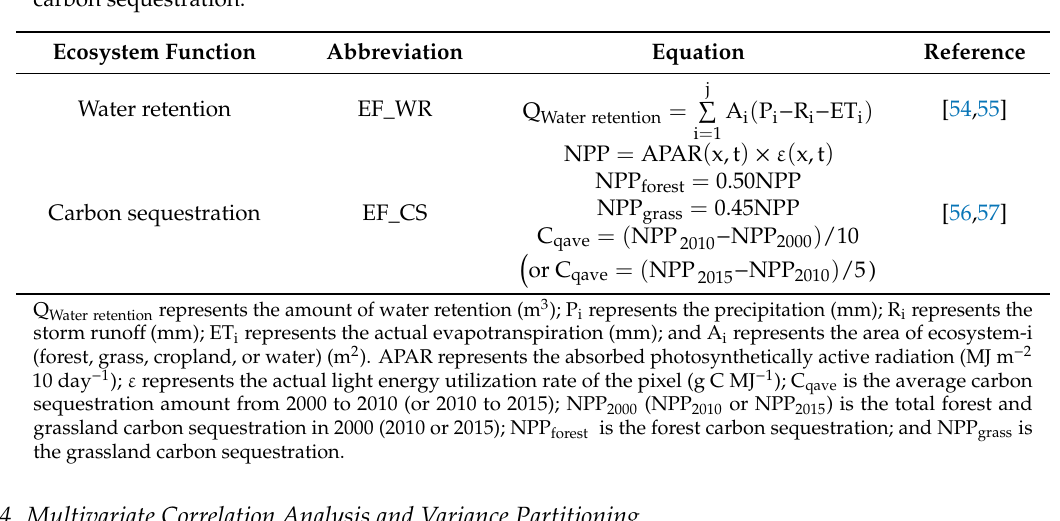
Table 2. Equations, abbreviations, and references used to calculate water retention and carbon